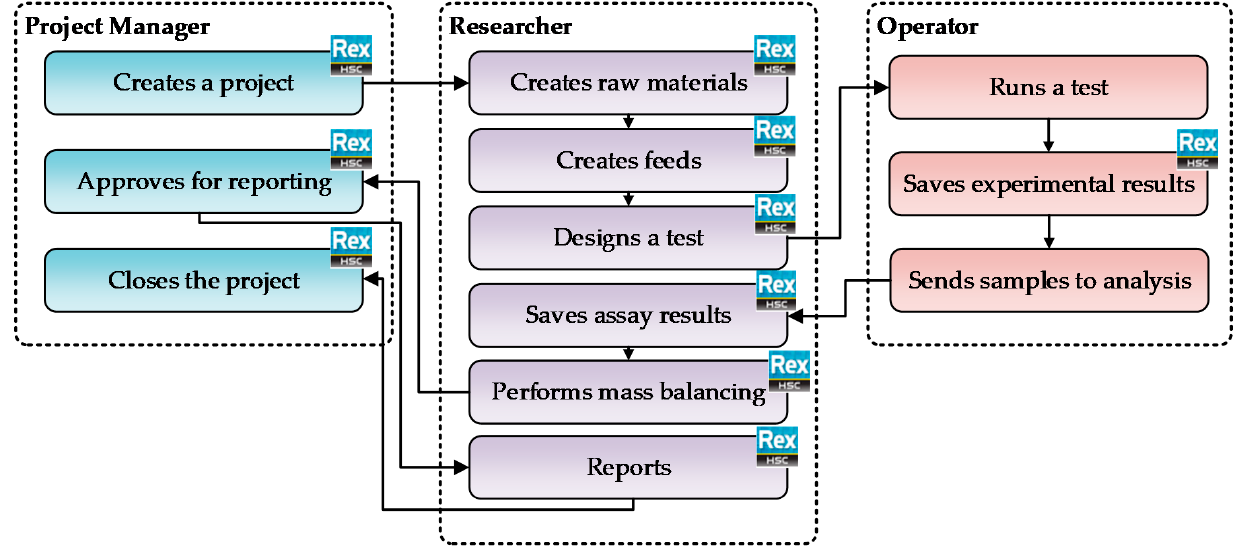
Figure 7. Project workflow in the HSC Rex system. The steps marked with the Rex icon are performed in the Rex.